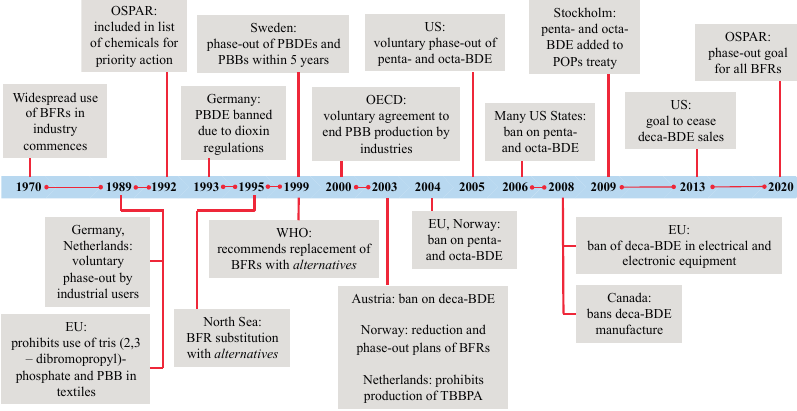
Figure 1. Timeline of legislative initiatives for brominated flame retardants spanning half